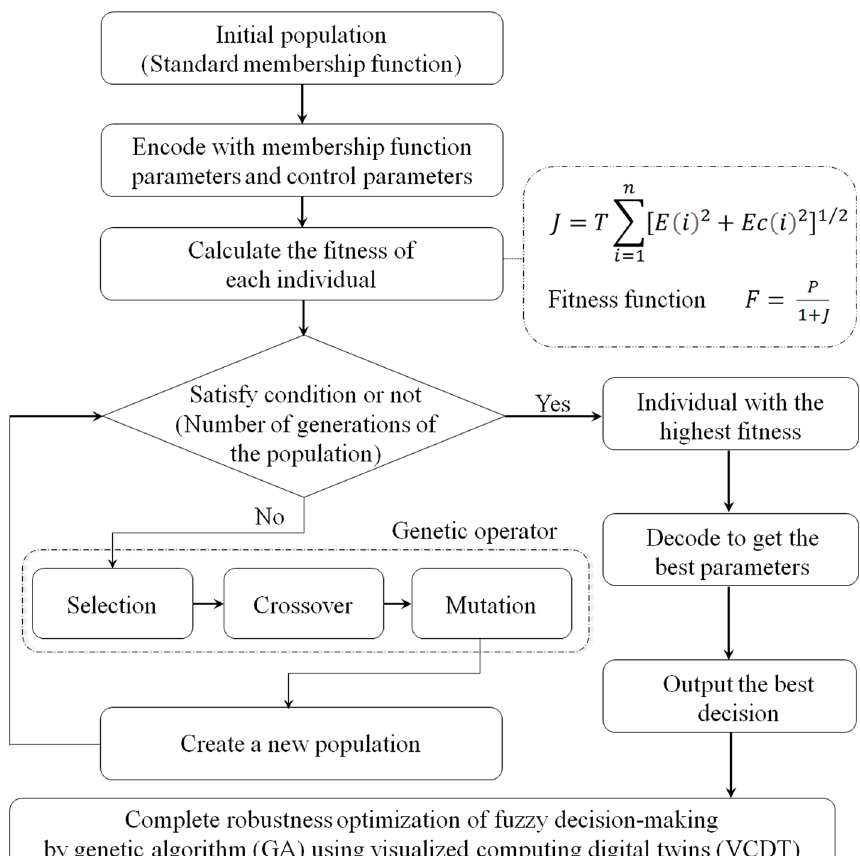
Fig. 1 Flowchart of the membership function of fuzzy decision-making optimized by a